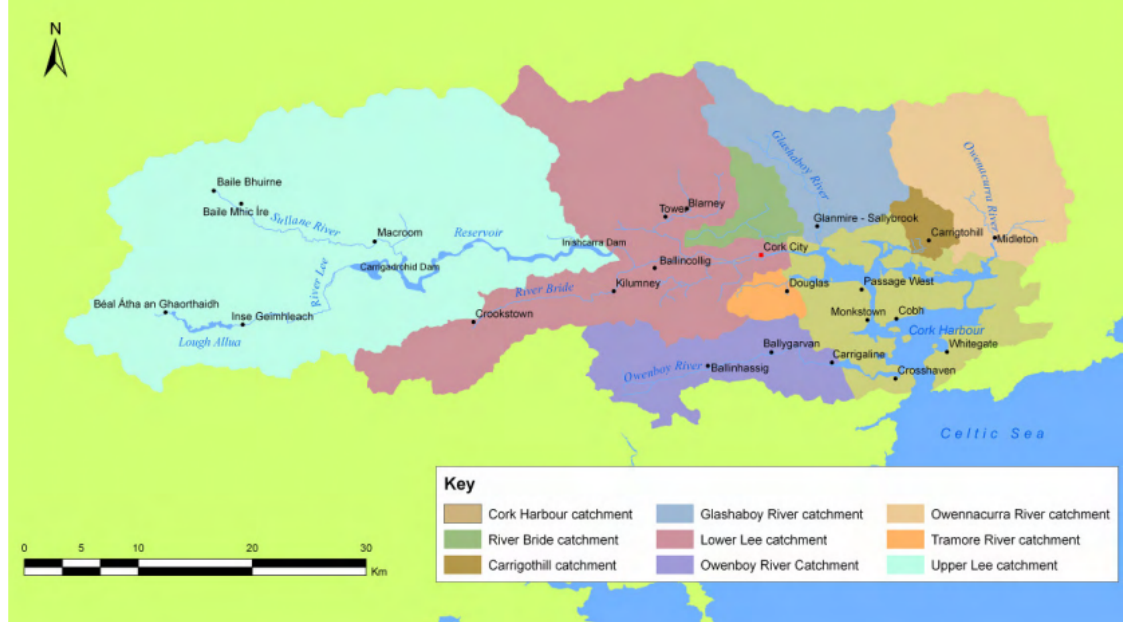
Figure 1. The nine sub-catchment areas of the Lee catchment. For the purposes of this study we are only interested in the Upper Lee and the Lower Lee sub-catchment areas, as the catchment areas designated the ’Lee catchment’ encompasses catchment areas of other rivers also [15]. (c) Office of Public Works, 2008, reproduced with